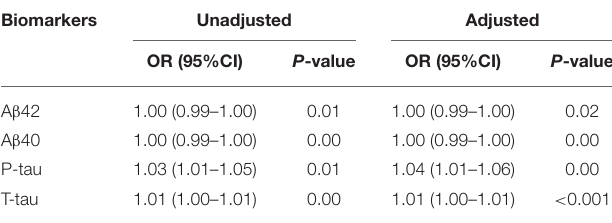
TABLE 4 | Relationship between SCD and biomarkers in CSF by logistic regression.